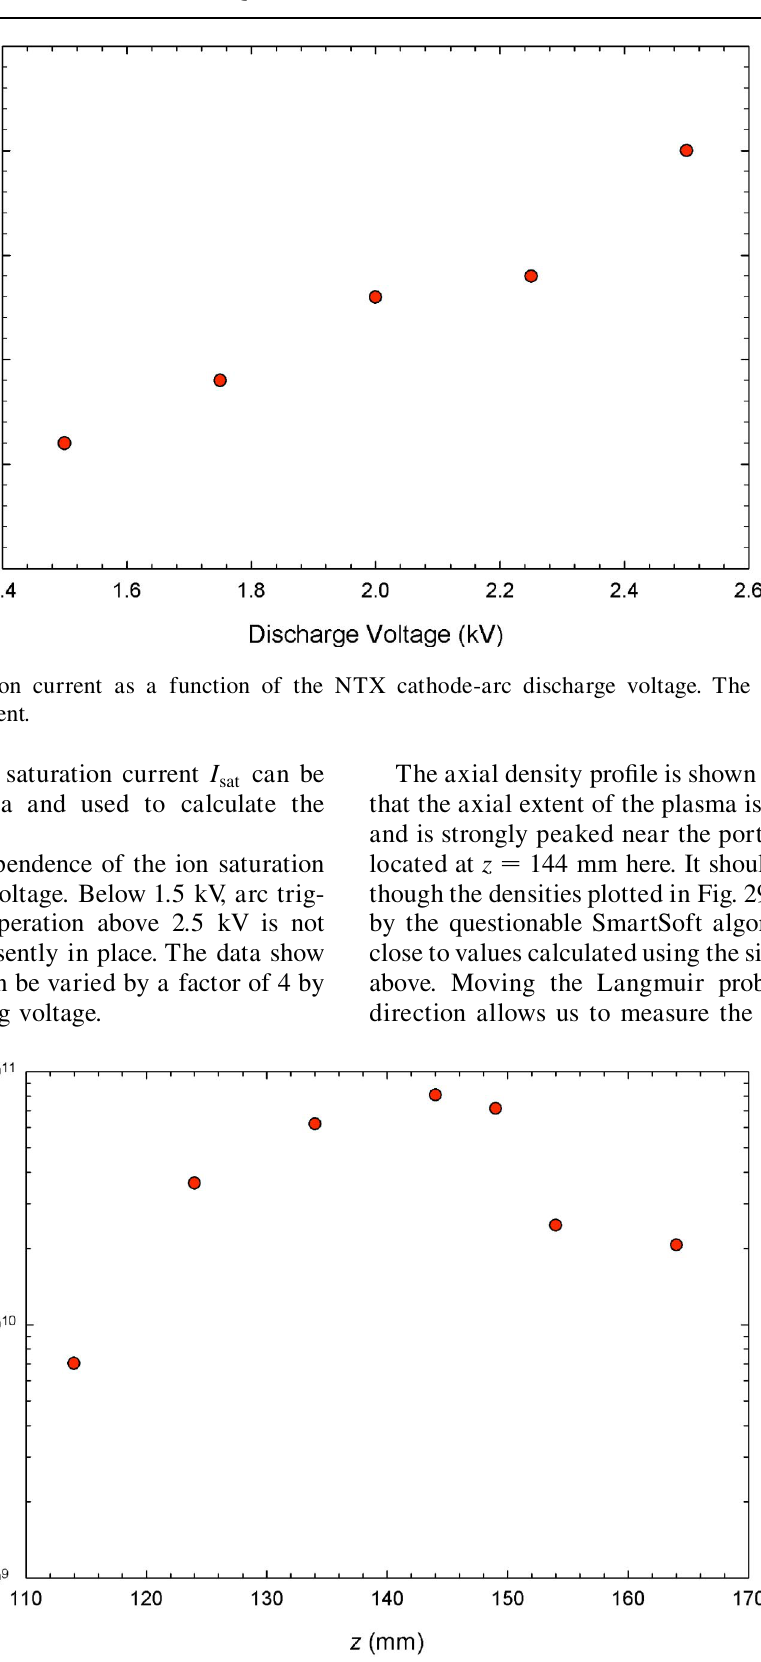
FIG. 29. (Color) Axial profile of the plasma density as a function of the longitudinal position near the plasma entry